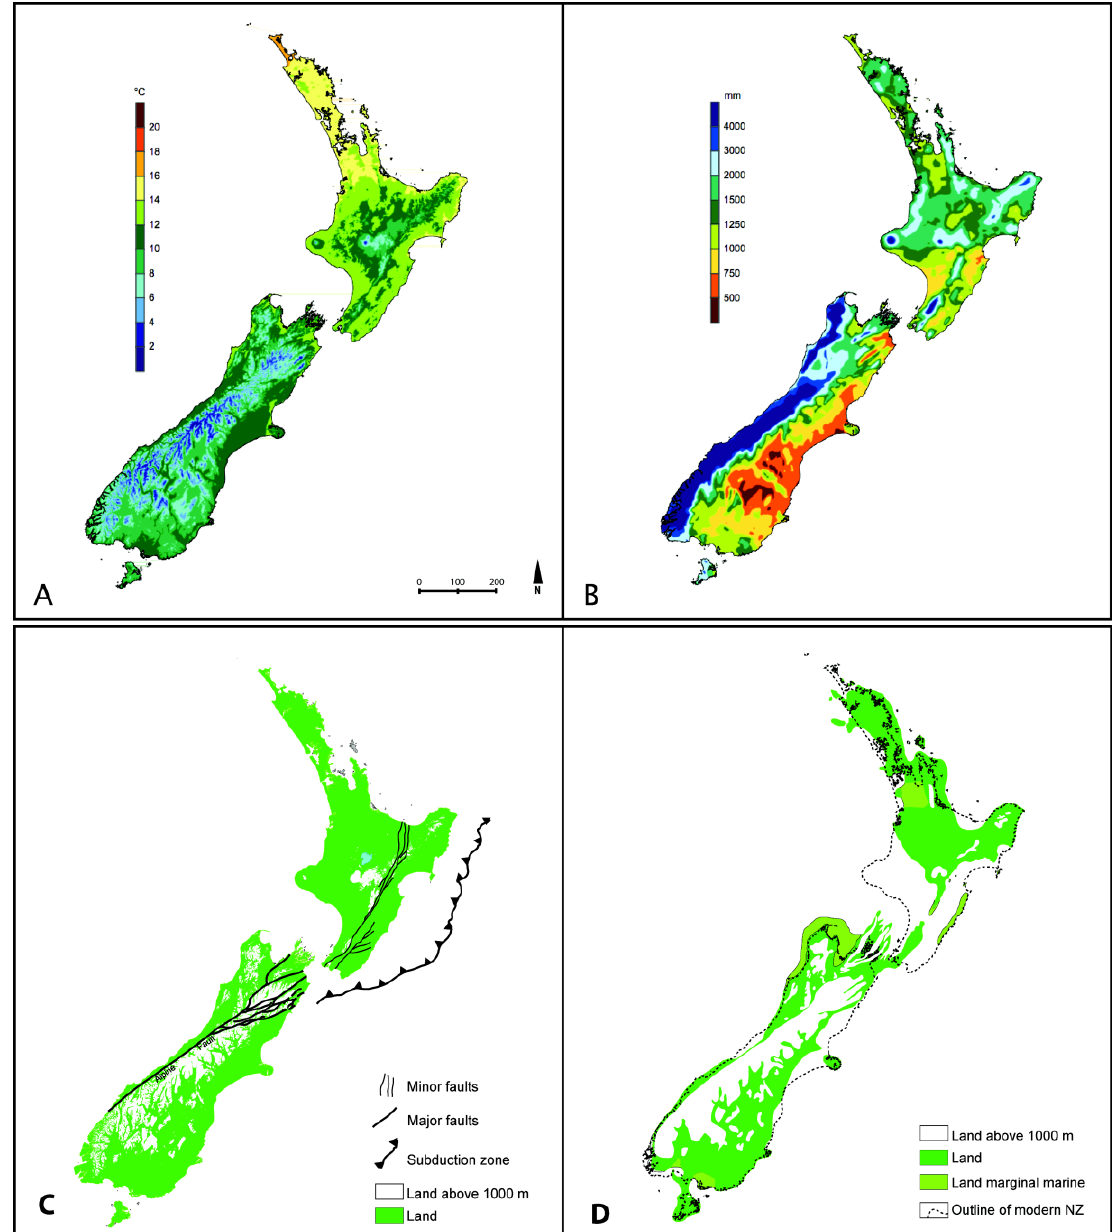
Figure 2. Geophysical and biogeographic features of New Zealand past and present. Environmental heterogeneity: A , mean annual temperature, B , mean annual rainfall, C , elevation. Temporal changes: D , Pliocene palaeogeography at 3 Ma, E , Pleistocene LGM, may yield uneven distribution of biodiversity ( F ). F , regional insect endemicity in a sample of 1724 species, % of species in a region that are endemic to that region (left), % of all 596 regional endemics that are endemic to a particular region (right). Thus phylogeographic (population) structure is a product of current and past environmental structure. Climate maps ( A , B ), courtesy of NIWA [91]. Palaeogeographic reconstructions ( D , E ) based on [92] and [93] respectively. Regional insect endemicity ( F ) from analysis of data in Fauna of New Zealand series volumes (2,3,12,15, 16,20–21,23,25,27,30,3–36,39– 50,53,54,57–59,62,63,65) containing suitable